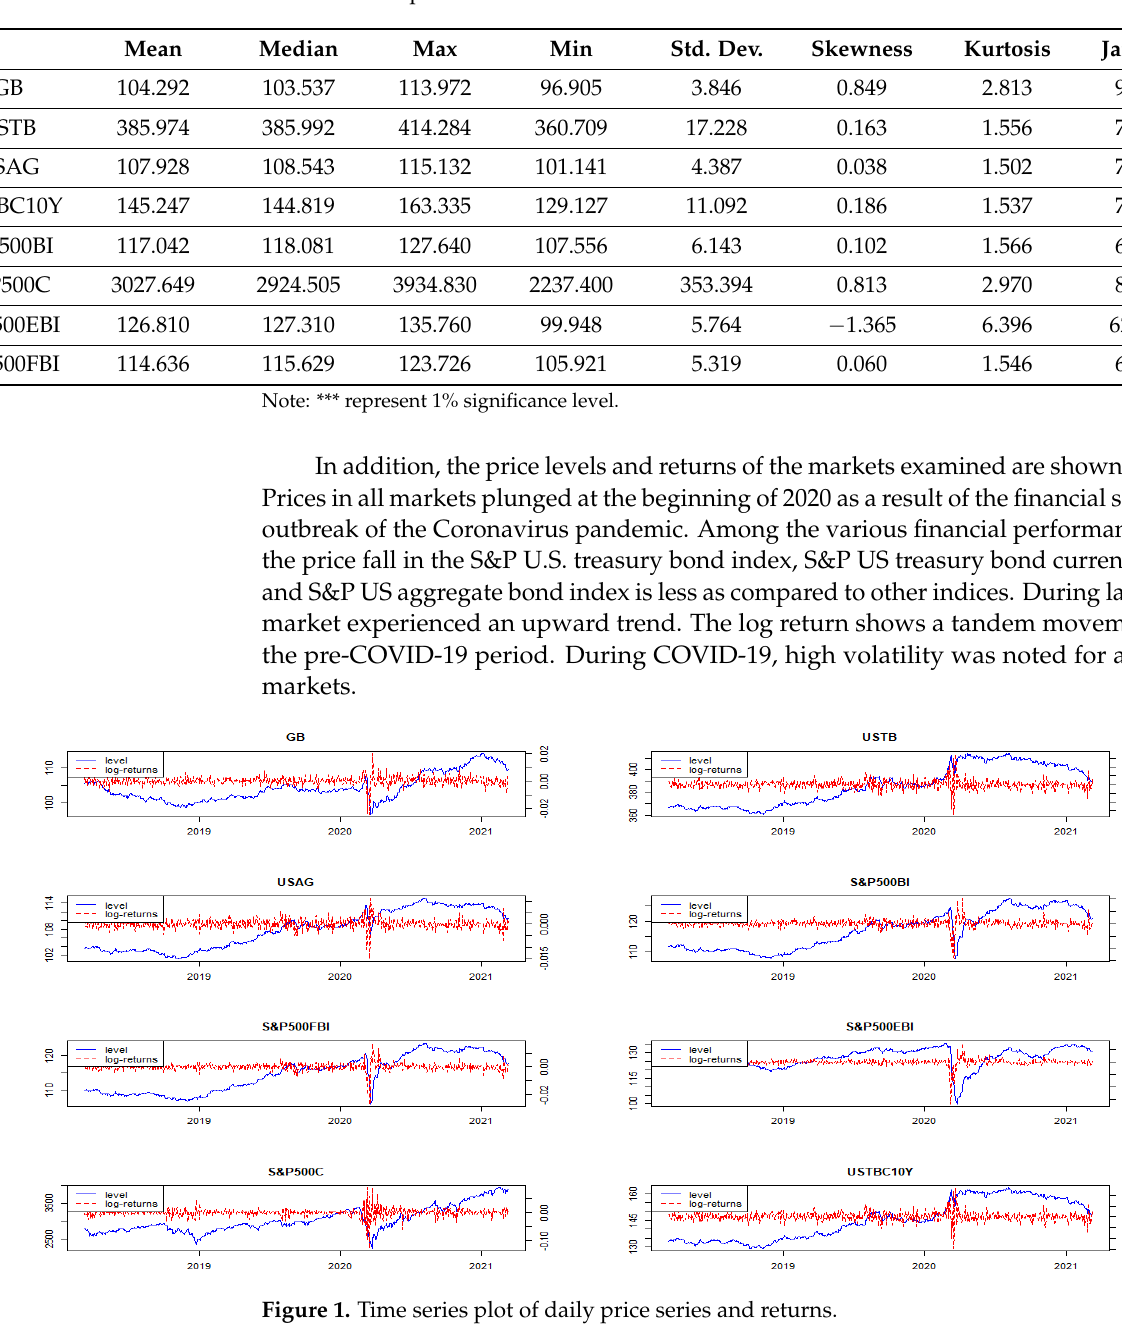
Table 2. Descriptive statistics.